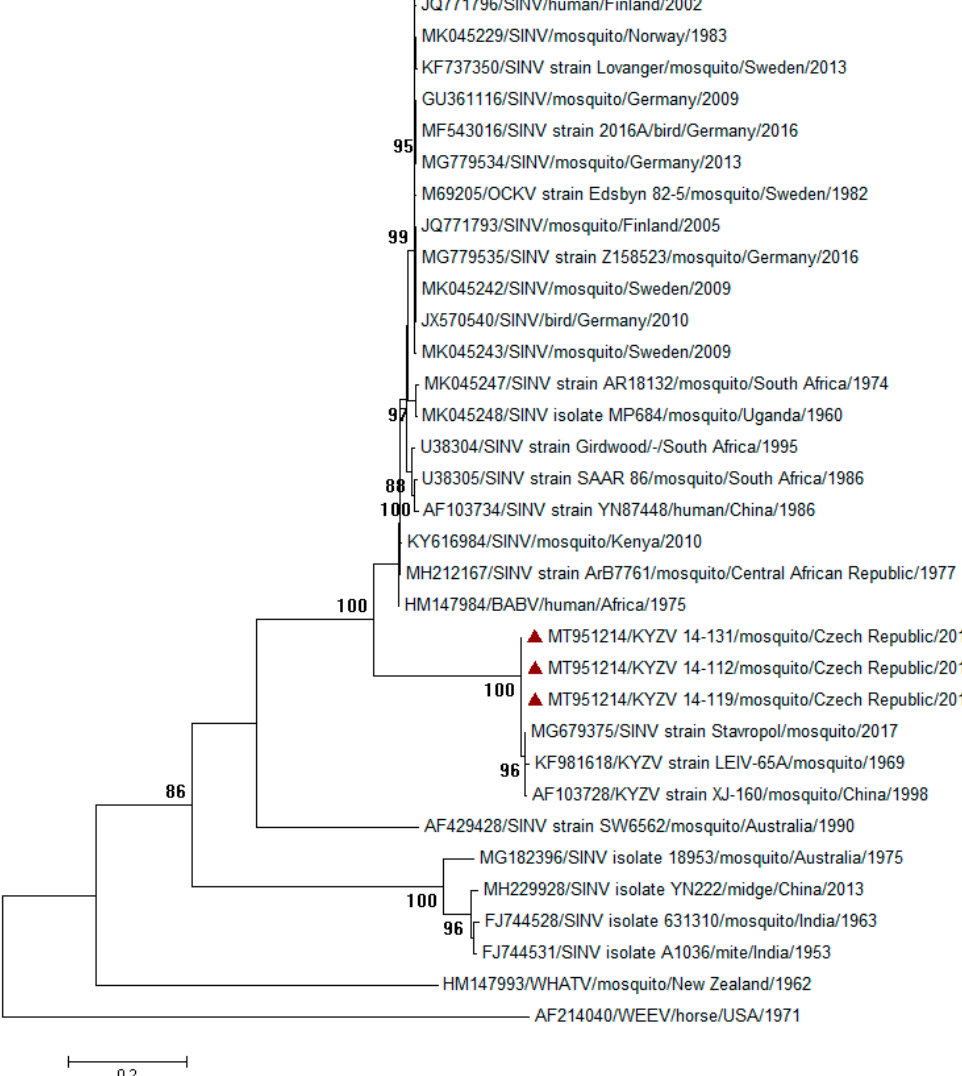
Figure 1. Phylogram demonstrating relationship of Kyzylagach virus (KYZV) detected in mosquitoes in the Czech Republic, based on a 1992-bp-long partial nucleotide sequence of the virus polyprotein gene from Czech sequences obtained in this work and other Sindbis virus strains circulating worldwide. Each record consists of particular accession number, source (human / mosquito / bird), place, and year of detection / isolation. Czech samples are highlighted by red triangles. Phylogenetic analyses were conducted using the maximum-likelihood (ML) algorithm using the general time-reversible model (MEGA 7.0). The robustness of trees was tested by bootstrap resampling of 1000 replicates, and its values are listed near the nodes (only values ≥ 85 are shown). The horizontal bar shows genetic distance. (Legend: BABV—Babanki virus; KYZV—Kyzylagach virus; OCKV—Ockelbo virus; SINV—Sindbis virus; WHATV—Whataroa virus; WEEV—Western equine encephalitis virus).